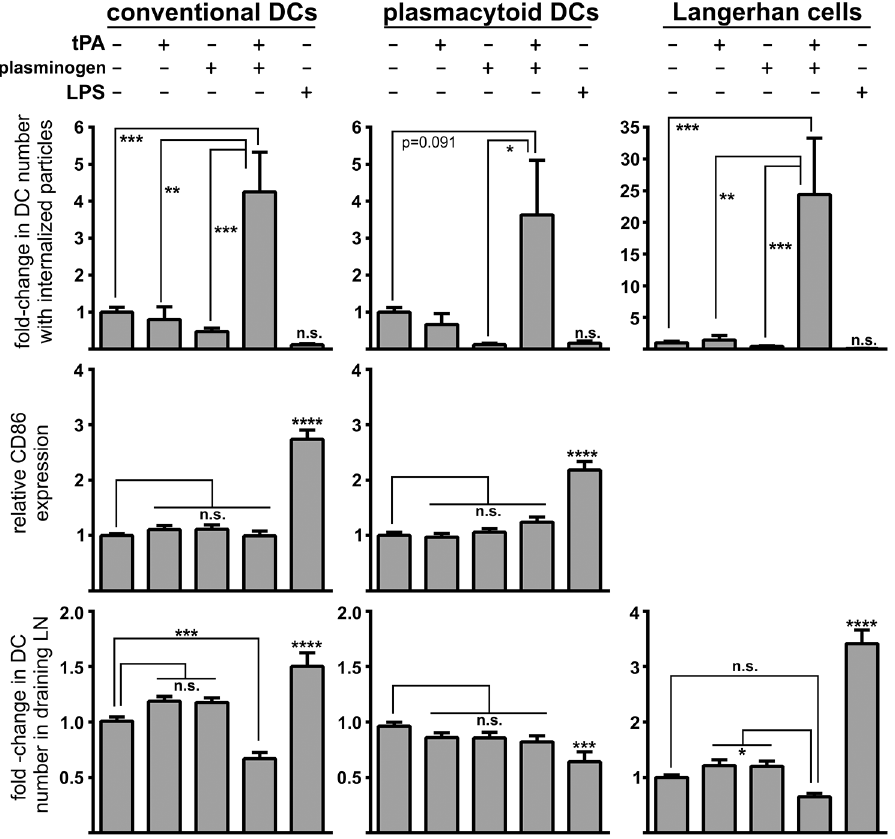
Fig 6. Intradermal plasmin injection increases the phagocytosis of microparticles by multiple mouse dendritic cell types in vivo , but does not trigger their maturation or migration to the draining lymph nodes. Mice were intradermally injected with microparticles in the presence/absence of 0.02 pmol of t-PA, 0.1 pmol of plasminogen or 10 μ g of LPS. 24 h after injection, the draining inguinal lymph nodes were harvested and single cell suspensions were stained for cell-surface markers (CD11c, CD11b, MHC class II, CD86 and B220) and subjected to flow cytometry. Events were gated into three populations: CD11c positive MHC class II positive conventional dendritic cells ( left column ), CD11b positive B220 positive plasmacytoid dendritic cells ( middle column ) and CD11c positive MHC class II positive CD11b positive CD207 positive CD103 negative Langerhans cells ( right column , note that CD86 analysis was not included for Langerhans cells). Within each dendritic cell population the percentage of cells with internalized particles ( top row ), their maturation status as determined by relative mean fluorescence intensity of CD86-staining ( middle row ), and their number relative to all cells within the draining lymph nodes (LN; bottom row ) were determined. Data are shown as mean ± s. e.m. (n = 8 – 11 independent experiments). * p < 0.05, ** p < 0.01, ** p < 0.001 and *** p < 0.0001 by 1-way ANOVA with Newman-Keuls post-hoc analysis. Two outliers were identified by Grubb ’ s test and excluded from the